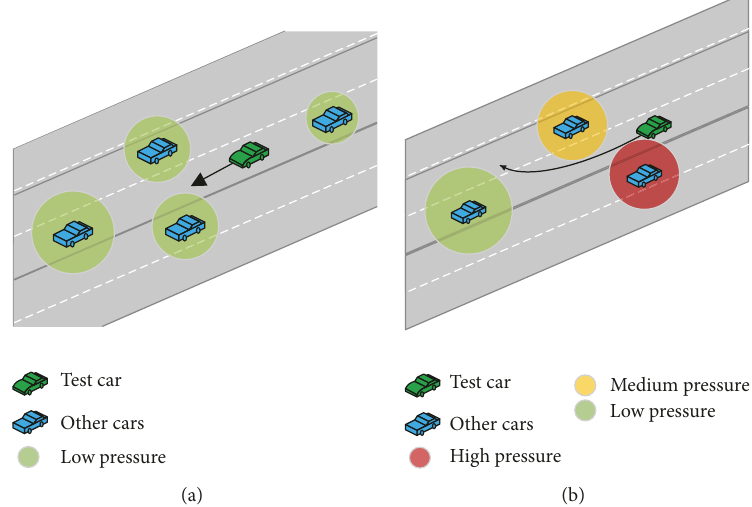
Figure 2: Illustration of CF behaviour (a) and LC behaviour (b) motivated by traffic environmental vision